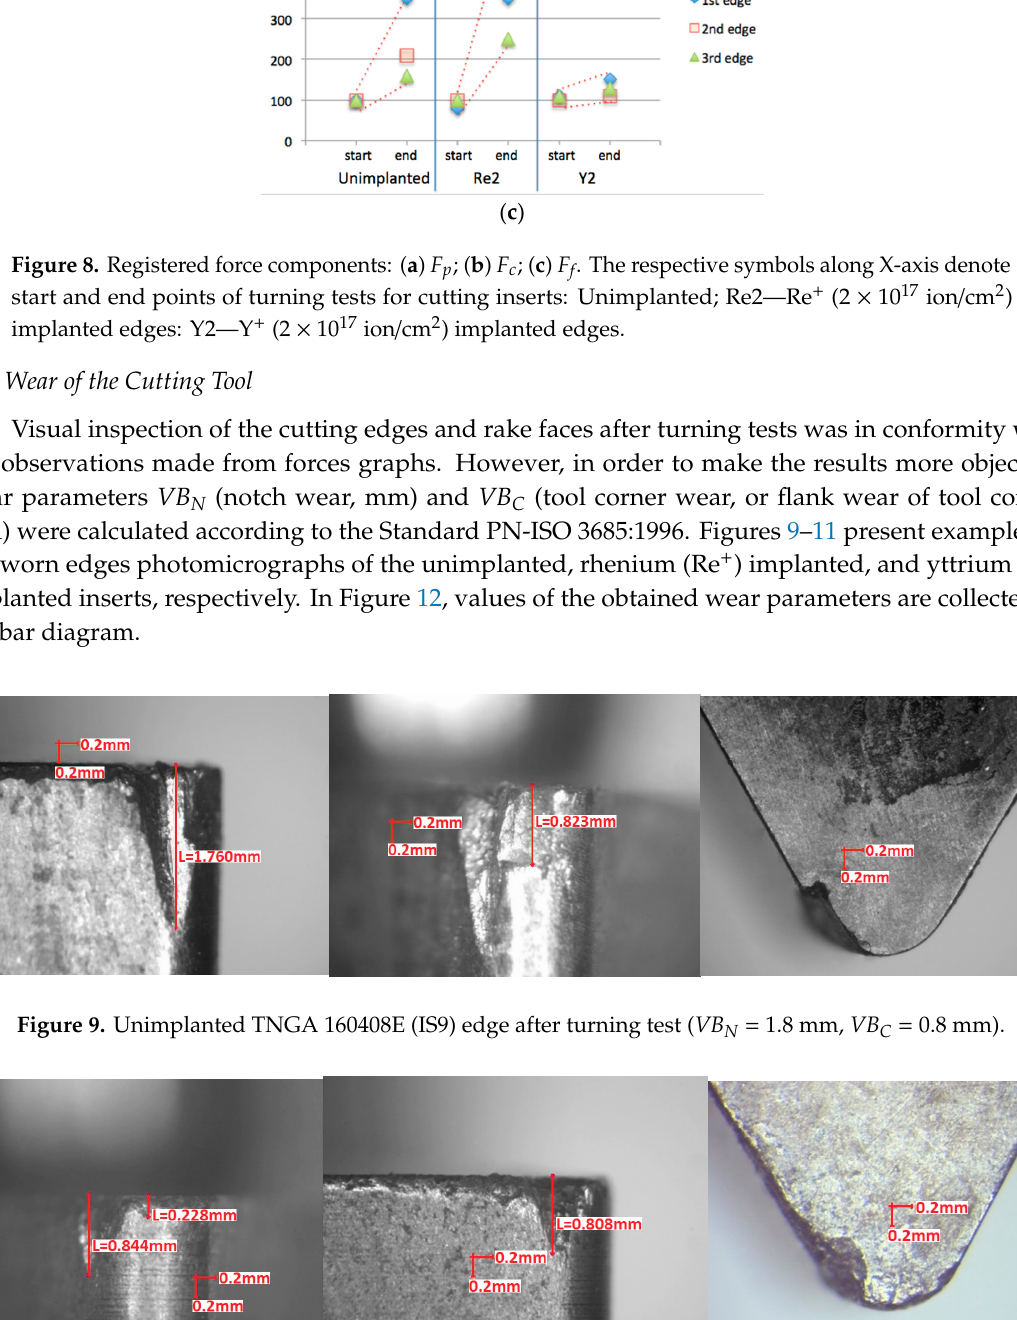
Figure 10. Rhenium implanted at dose 2 × 10 17 ion/cm 2 TNGA 160408E (IS9) edge after turning test ( VB N = 0.8 mm, VB C = 0.2 mm).